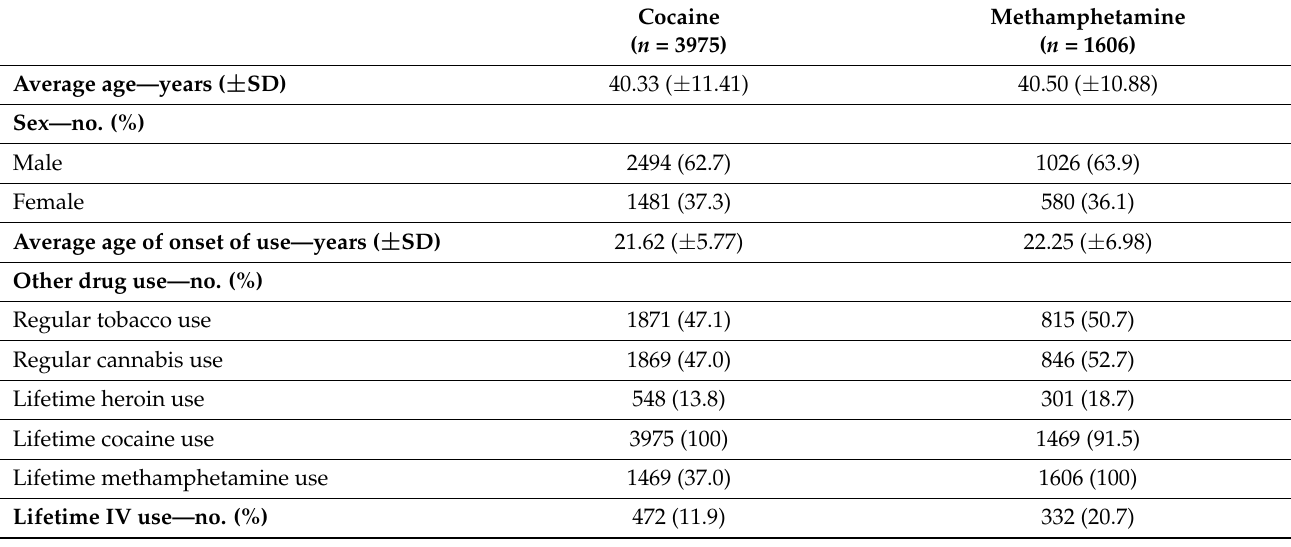
Figure 3. Demographic characteristics of people reporting lifetime use of cocaine and methamphetamine in the NHANES 2005–2018. A represents Education Level and B represents Annual Household Income. Numbers on each wedge represent percent of the sample with the characteristic of interest, rounded to the nearest whole number. GED = General Educational Development Test. Table 2. Demographic and other drug use characteristics of the sample reporting lifetime use of cocaine and metham- phetamine in the NHANES